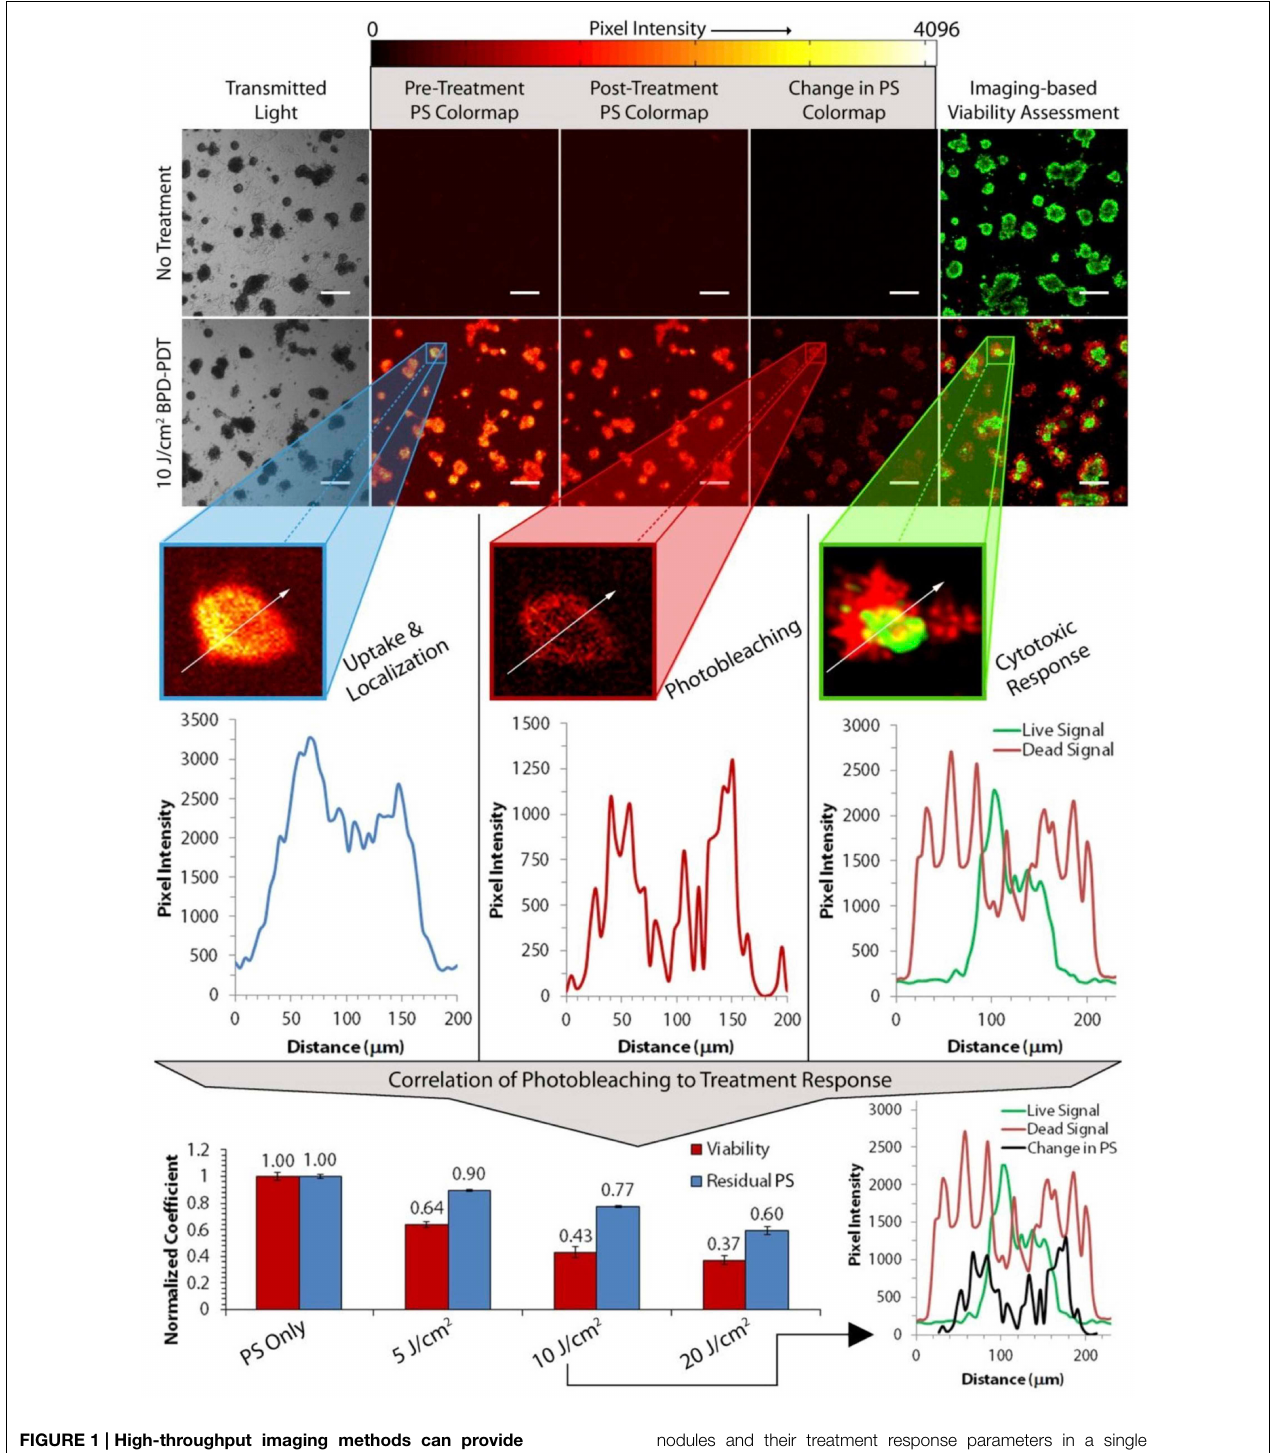
nodules and their treatment response parameters in a single experiment. For example, by monitoring the change in photosensitizer fluorescence (“Change in PS” column), one can monitor photosensitizer photobleaching to infer and correlate photosensitizer activity with therapeutic